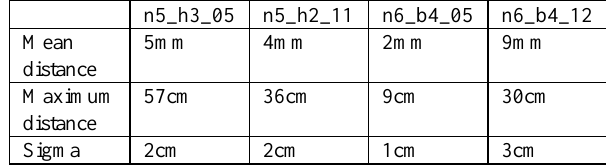
Table 1: Distance between the laser data and various image 3D point